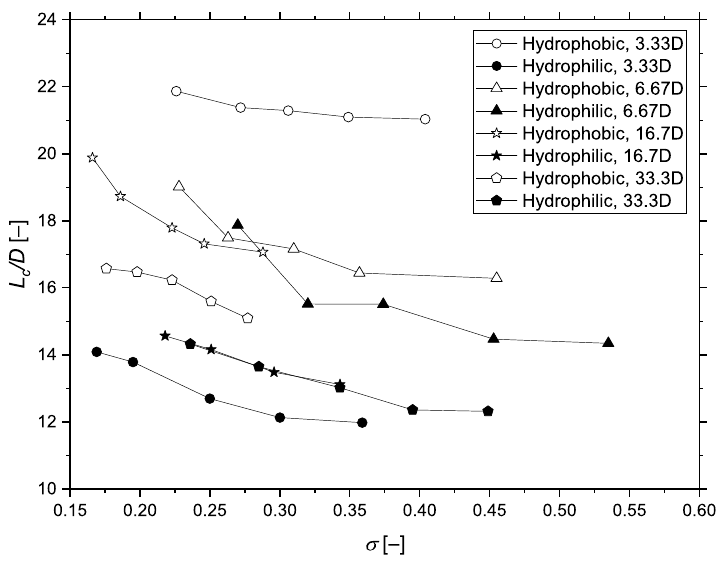
Figure 8. Relationship between dimensionless cavitation length and cavitation